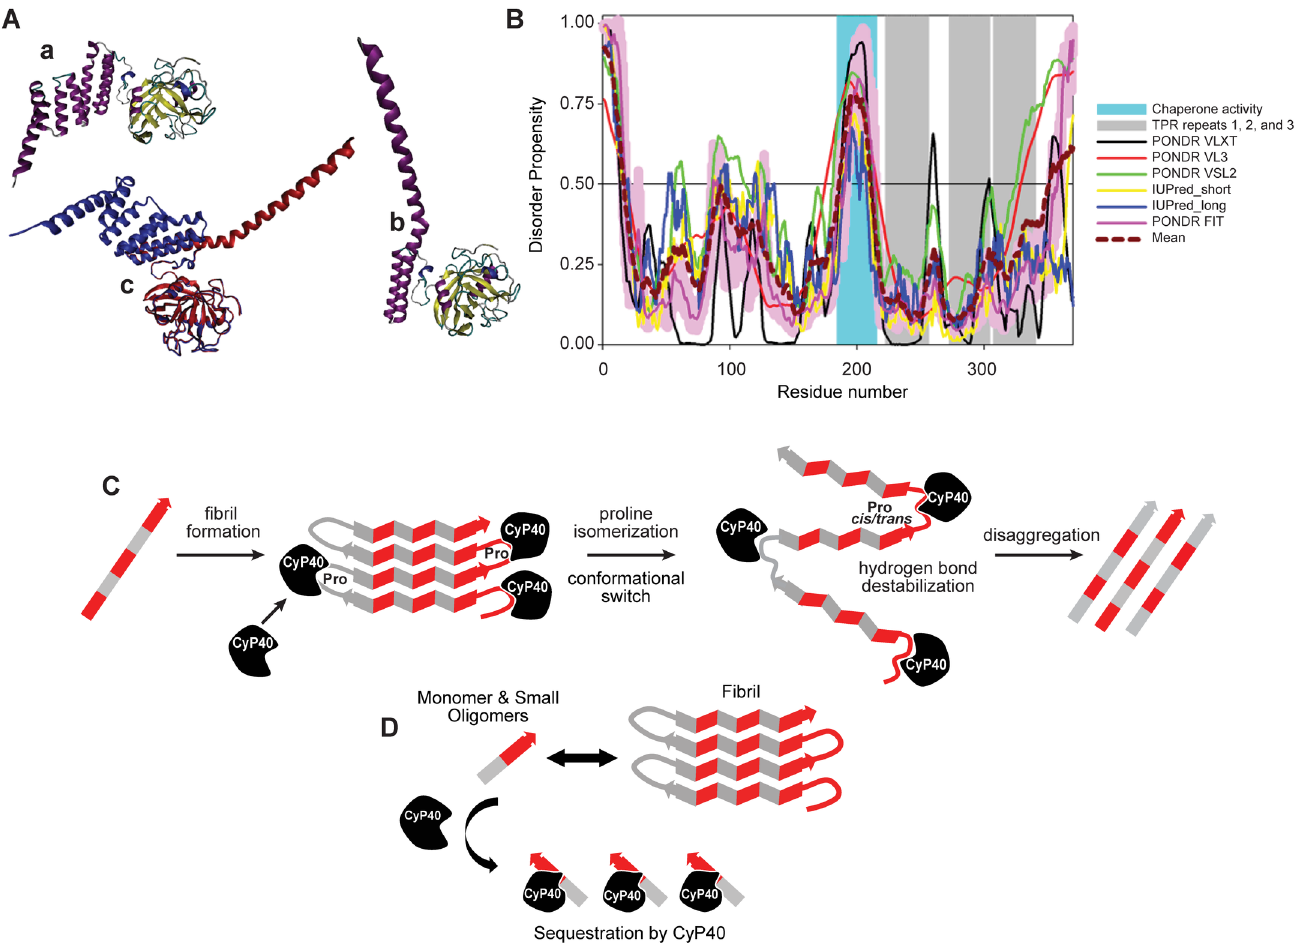
Fig 8. Cyclophilin 40 (CyP40) conformation, disorder prediction, and putative disaggregase mechanisms. (A) Structural characterization of bovine CyP40: a, crystal structure of the monoclinic form of CyP40 (Protein Data Bank [PDB] ID: 1ihg); b, crystal structure of the tetragonalform of CyP40 (PDB ID: 1iip). Structures in plots a and b are colored accordingto the secondary structure content; c, multiplestructural alignmentof the monoclinic (blue) and tetragonal(red) forms of CyP40 conducted by MultiProt platform. (B) Evaluatingintrinsicdisorderpropensityof human CyP40 (UniProt ID: Q08752)by a series of per-residue disorderpredictors. Disorder profilesgeneratedby Predictor of NaturallyDisordered Regions(PONDR) VLXT, PONDR VL3, PONDR VSL2, IUPred_short, IUPred_long, and PONDR FIT are shown by black, red, green, yellow, blue, and pink lines, respectively.The light pink shadowaroundthe PONDR FIT shows error distribution. The cyan-shaded area shows the positionof the regionwith chaperoneactivity. The positionsof 3 tetracopeptide repeat (TPR) motifs are shown as gray-shadedareas. In these disorderanalyses, the predicted intrinsic disorder scores above0.5 are considered to correspond to the disorderedresidues/regions. (C) Schematicrepresentation of hypothesized enzymatic activity-basedCyP40 disaggregation. (D) Schematic representation of hypothesized interaction-based CyP40 disaggregation.